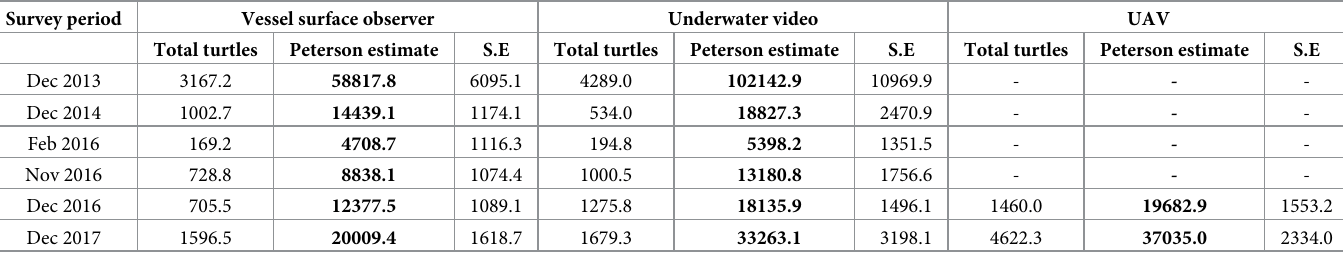
Table 2. Mean values for total mature female turtles counted and Lincoln Peterson estimates for periods surveyed by each method with standard error. Survey period